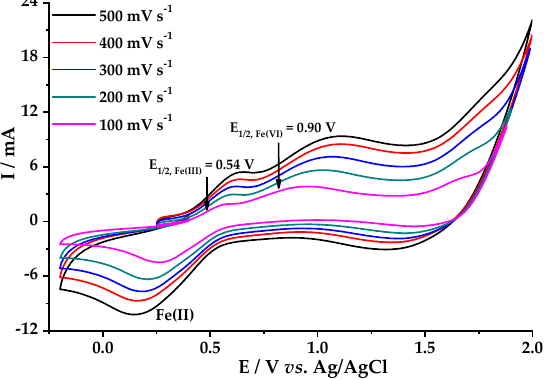
Figure 1. Behavior of 6 mM FeSO 4 at different voltammetric scan rate, in 0.1 M HClO 4 , on 0.5 boron- doped diamond (BDD) cm 2 as working electrode; counter electrode—platinum wire.